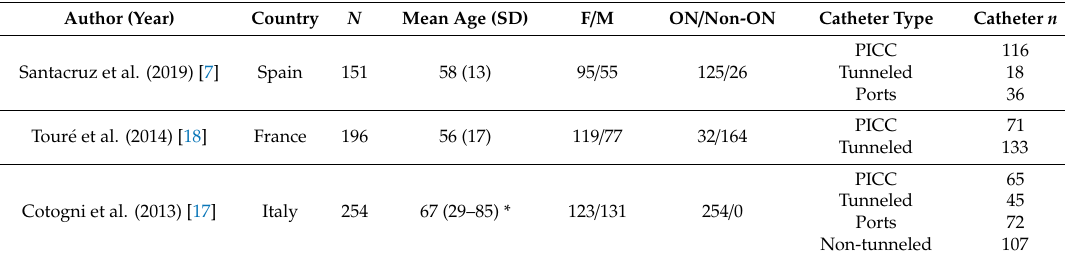
Table 1. Characteristics of the selected studies and patient demographics.